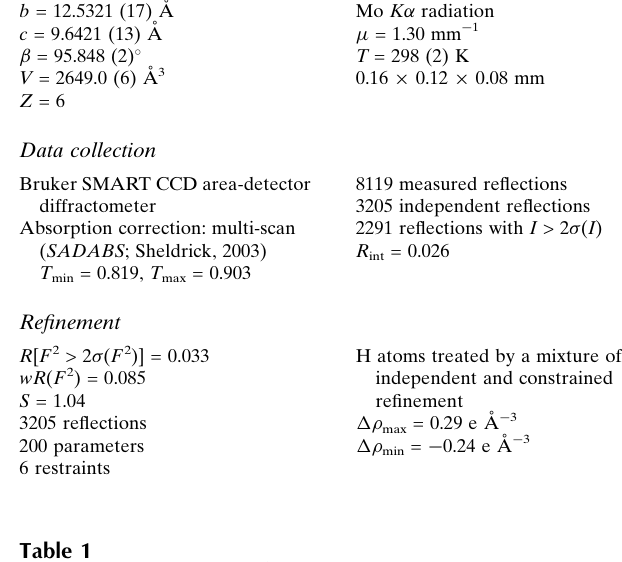
Hydrogen-bond geometry (A˚ , (cid:3)